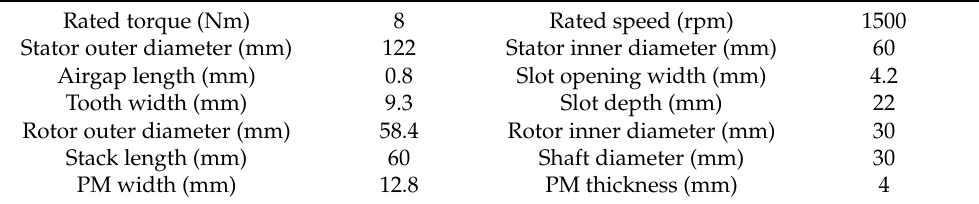
Table 6. Motor data of the